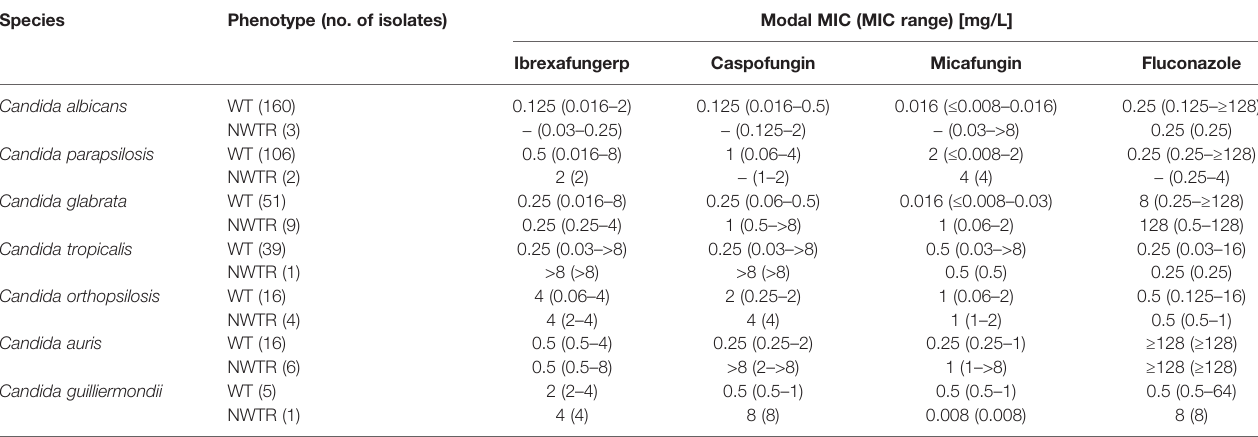
TABLE 3 | MICs distribution of ibrexafungerp and comparator antifungal drugs against echinocandin wild-type (WT) and non-wild-type/resistant (NWTR) Candida spp. Isolates.